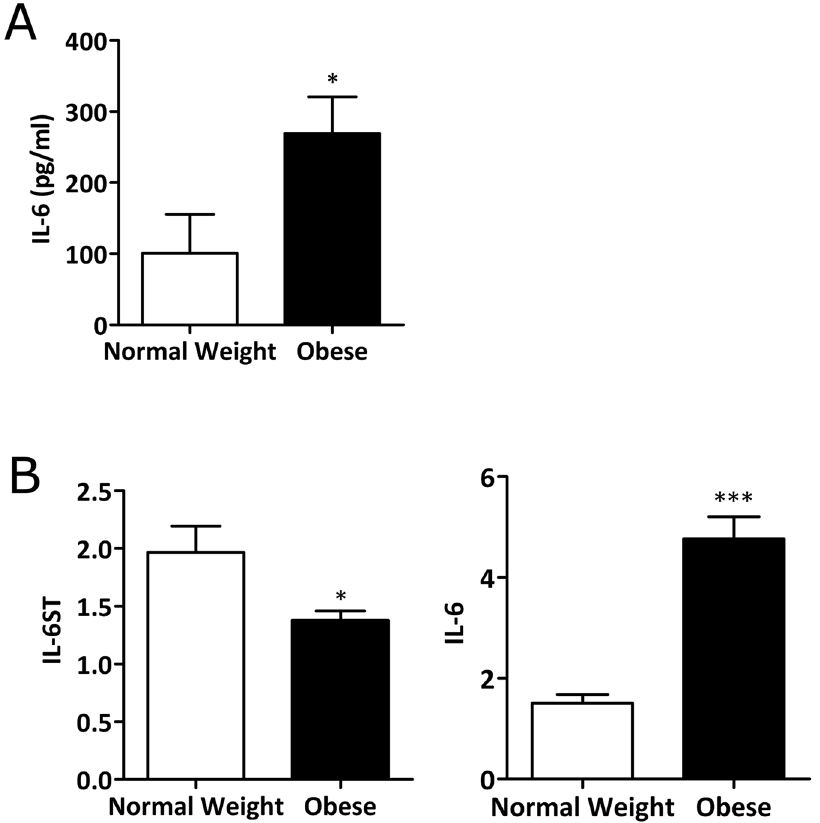
Figure 2. Synovial fibroblasts from obese OA patients secrete more IL-6 than cells from normal weight patients. ( A ) Secretion of IL-6 at baseline from normal weight (n = 4) and obese synovial fibroblasts (n = 4), as measured by ELISA. Data are mean ± SEM * p < 0.05. ( B ) mRNA expression of IL-6ST (gp130) and IL-6 as determined by quantitative real-time PCR. Data are mean ± SEM (normal weight n = 6; obese n = 12). Statistical significance was determined by Mann-Whitney U test where * p < 0.05, and *** p <